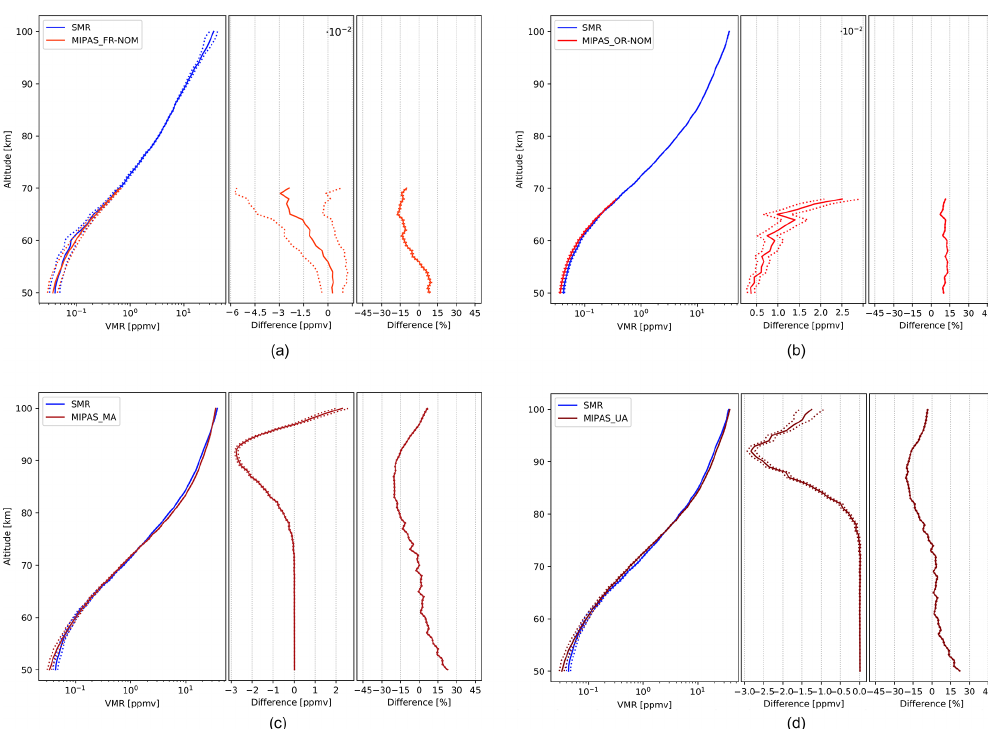
Figure 9. Comparison of SMR CO concentrations with the ones from MIPAS FR-nominal (a) , OR-nominal (b) , middle atmosphere (c) and upper atmosphere (d) modes. The data plotted are global averages over the whole time periods indicated in Table 2. (Left subpanels) Volume mixing ratios, expressed in parts per million by volume (ppmv). (Center subpanels) Absolute differences, expressed in ppmv. (Right subpan- els) Relative differences, expressed in percentage. The dashed lines represent the standard deviation of the median which, in some cases, is smaller than the thickness of the profile line, causing the dashed line not to be